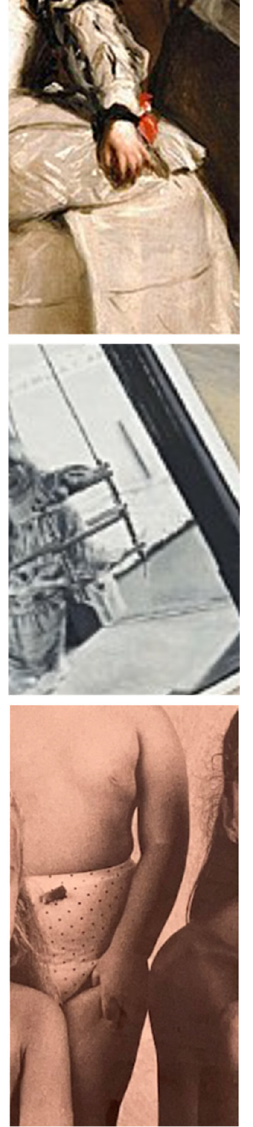
Figure 1. The girls’ left hands, details ( Top ) (Velázquez 1656). ( Middle ) (McKenzie 2021). ( Bottom ) (Author’s own picture (2021) of printed ad for the author’s family business, circa